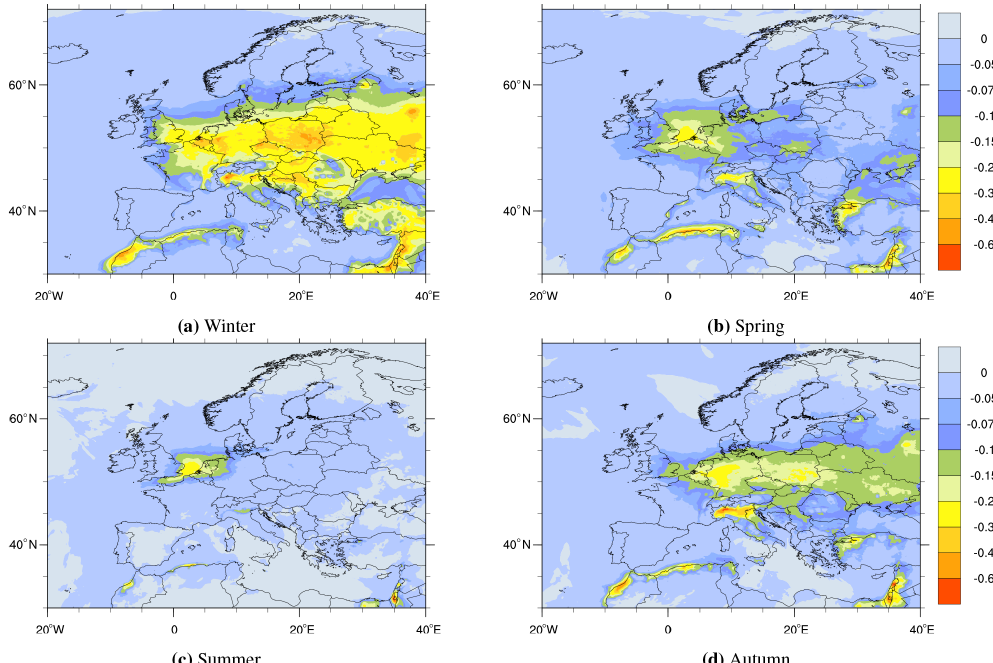
Figure 7. Effects of a 10% decrease in 2030 NH 3 emissions on PM 2 . 5 (µgm − 3 ) split by season. Winter: December, January, and February. Spring: March, April, and May. Summer: June, July, and August. Autumn: September, October, and